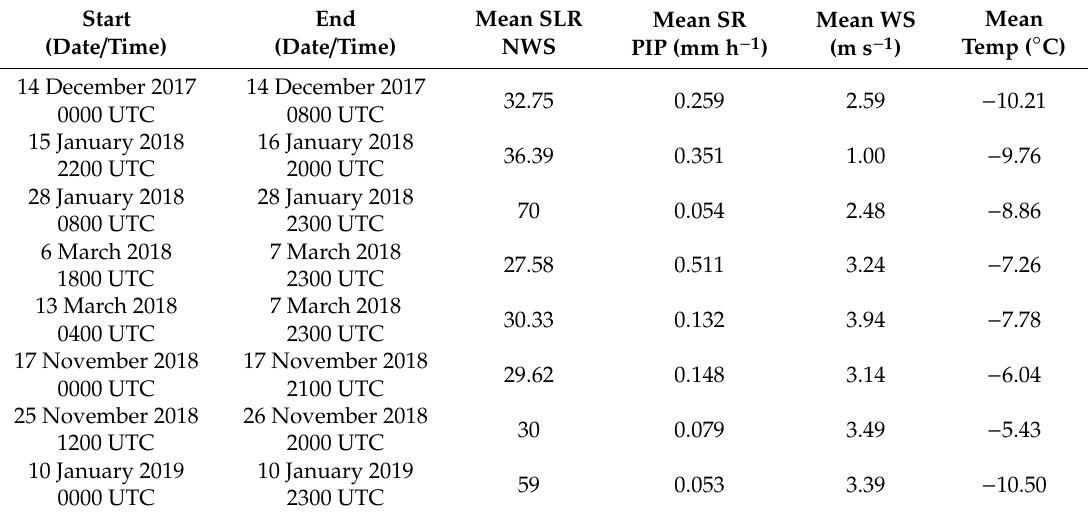
Table 2. This is a table of the eight high SLR snow events used in this work. Organization follows that of Table